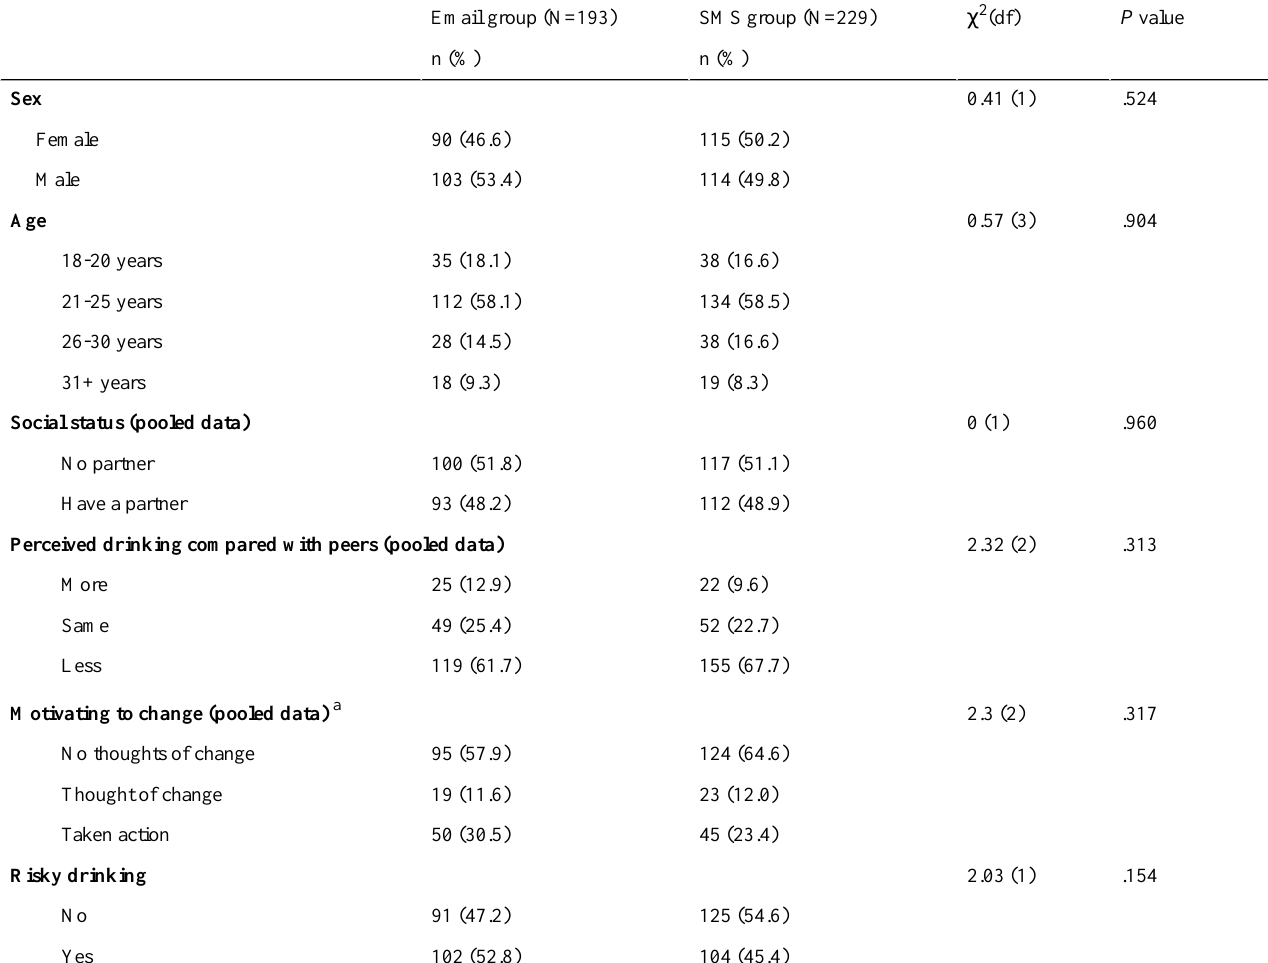
Table 2. Characteristics of the students in the SMS (N=229) and email groups